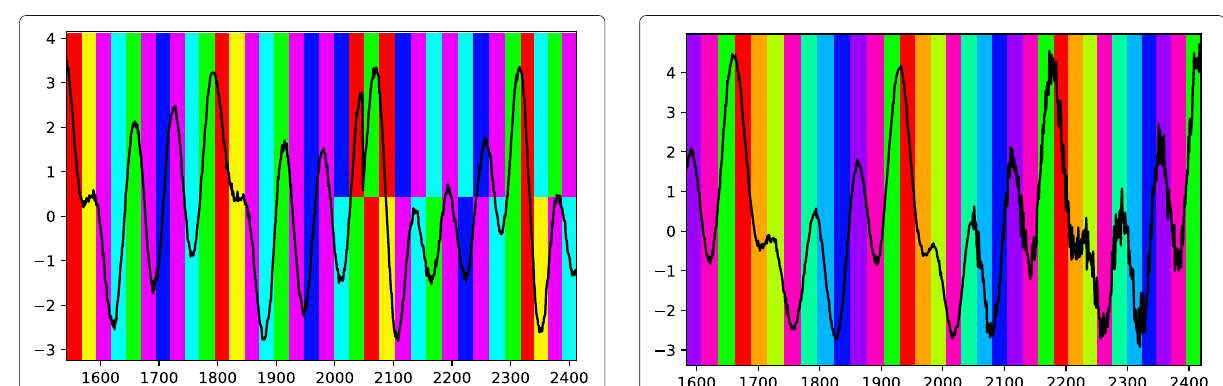
Fig. 9 Classifier with n 0 = 10, n n 0 = 6 applied to wave with abnormal